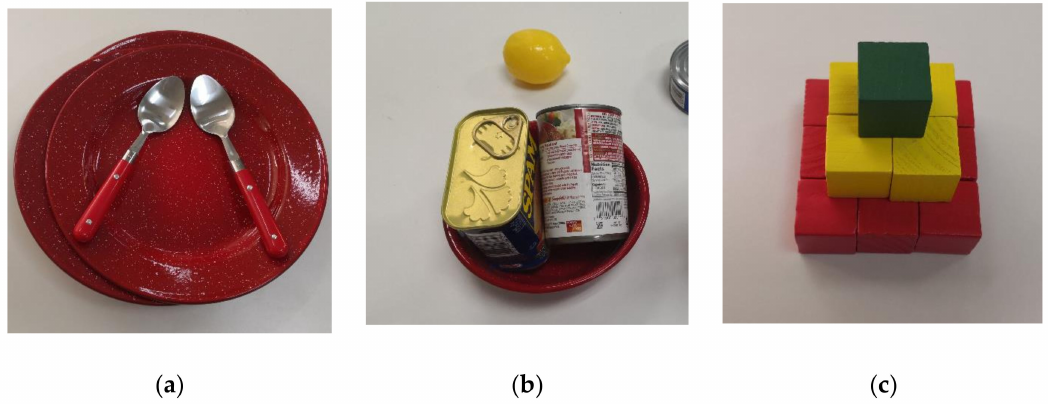
Figure 1. Multi-step operations for in cluttered scenes. ( a ) Move the plate with spoons on it; ( b ) Put a lemon into a full bowl; ( c ) Stack blocks like a